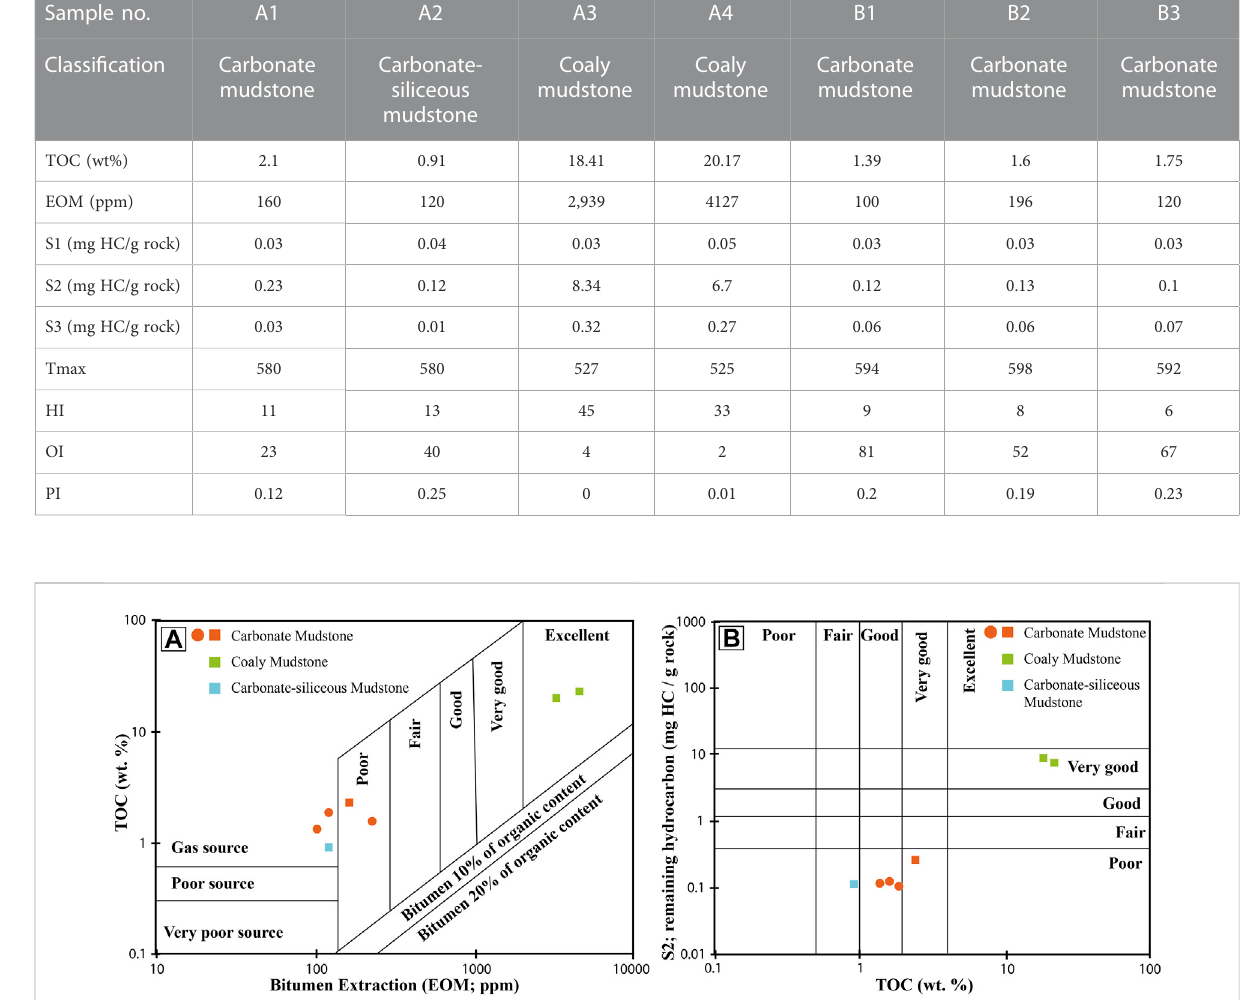
FIGURE 6 (A) Total organiccarbon(TOC)andextractableorganicmatter(EOM)cross-plotshowingthehydrocarbongenerationpotential ofthesamples. (B) Cross-plot of TOC and remaining hydrocarbon potential (S2) showing the hydrocarbon generating potential of the studied formations. The red rectangle, green rectangle, and blue rectangle represent the samples from location A, while the red dot denotes the samples from location